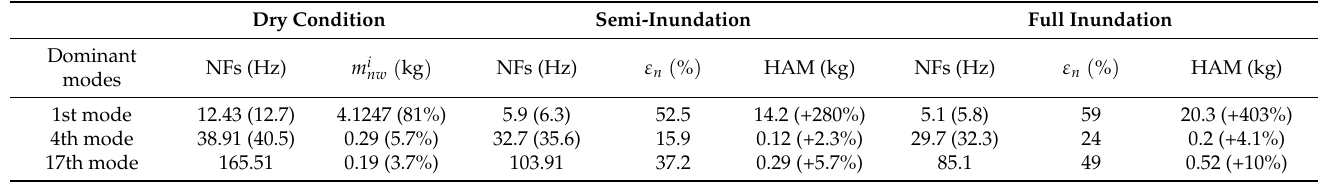
Table 2. Experimental and numerical NFs, effective modal mass, and HAM for the small-scale